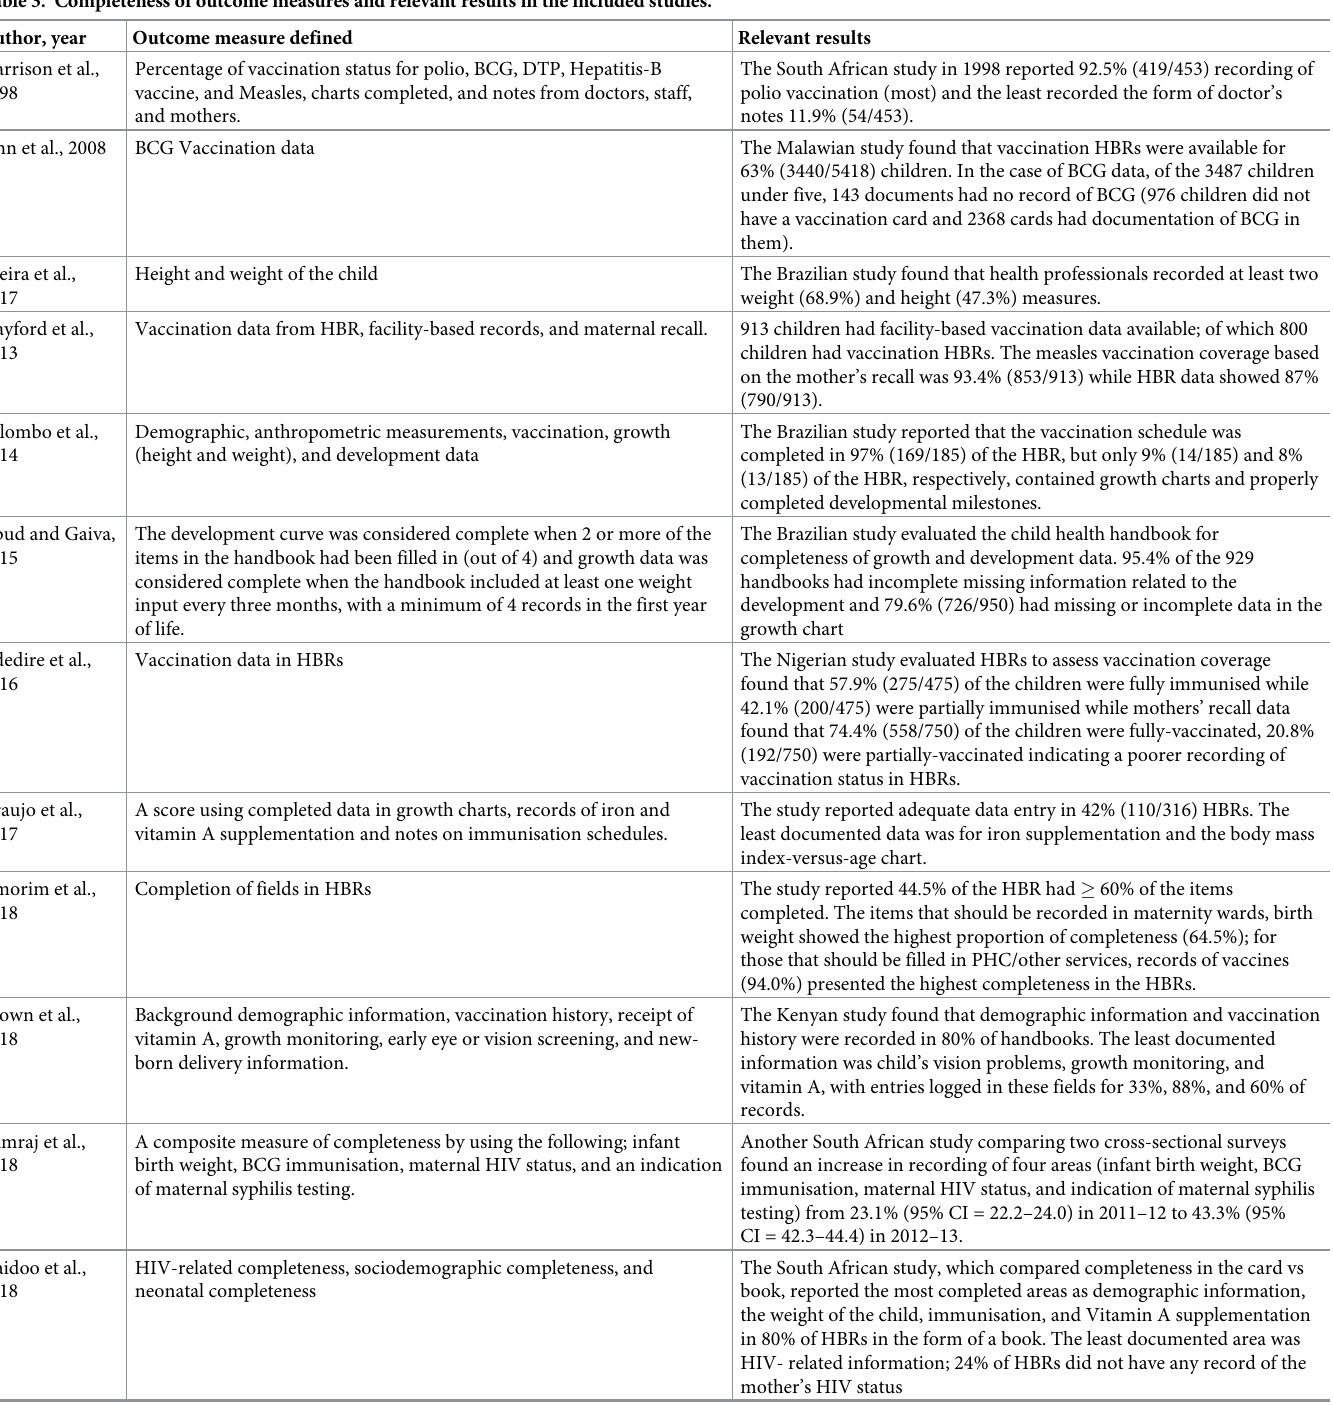
Table 3. Completeness of outcome measures and relevant results in the included